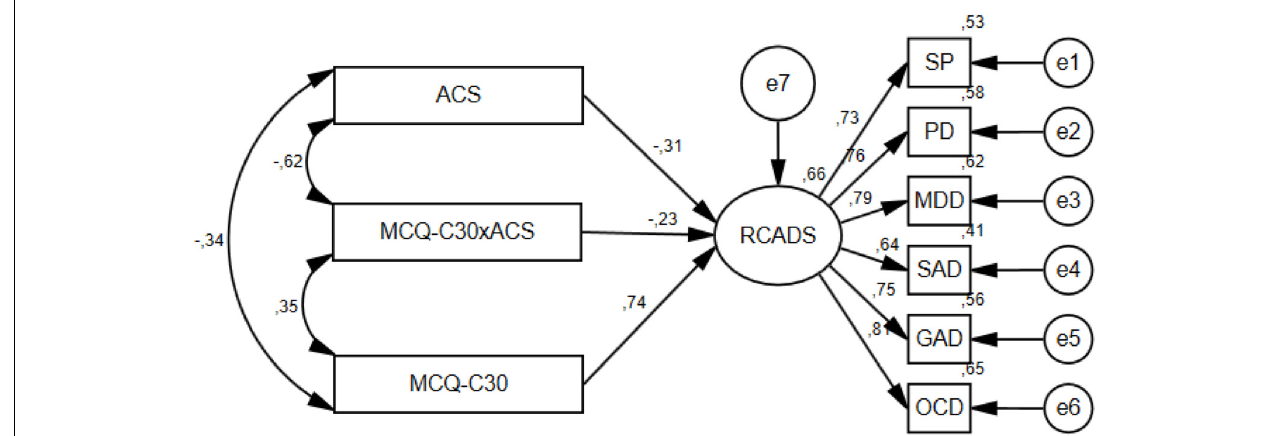
FIGURE 1 | Structure and standardized estimates of the best fitting model in the community group.